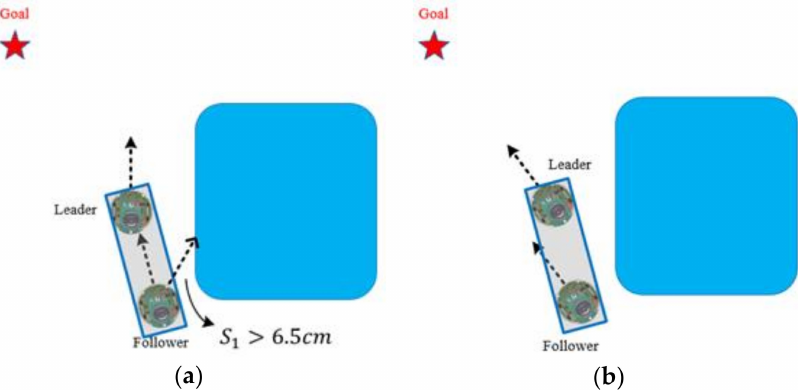
Figure 21. ( a ) Distance between follower and obstacle is larger than 6.5 cm; ( b ) Robots switch the WFM back to the